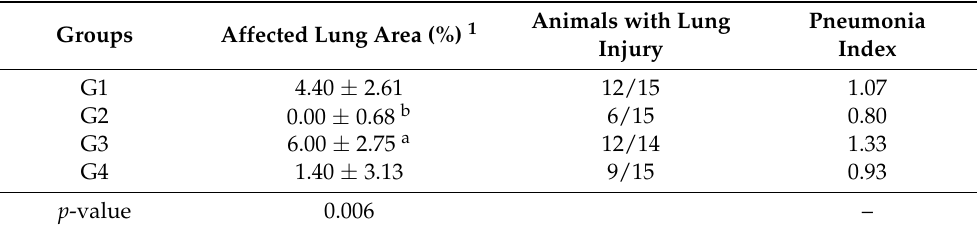
Table 2. Percentage of pulmonary consolidation lesions determined by macroscopic evaluation and Pneumonia Index for G1 to G4 and a group of challenged